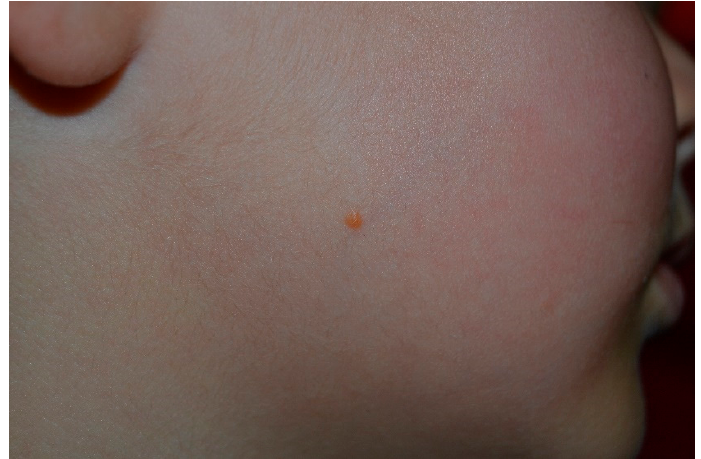
Figure 13. Yellowish papule of the right side of the face, compatible with the diagnosis of juvenile